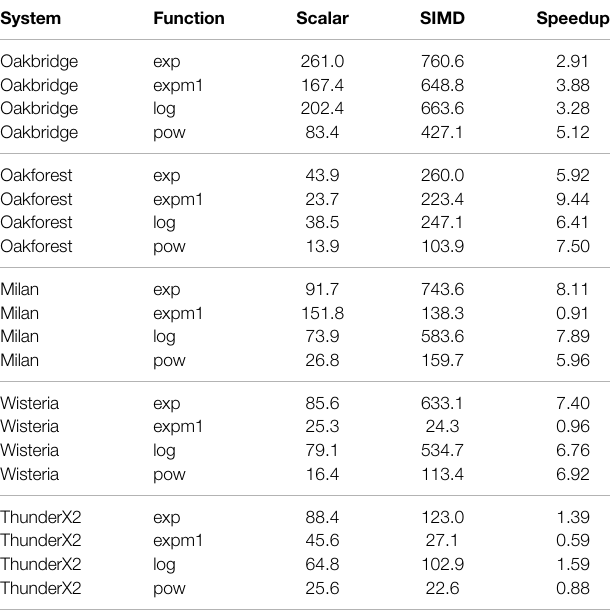
TABLE 4 | Single-threaded performance of scalar and vectorised math library calls. The units for the Scalar and SIMD columns is millions of function evaluations per second.